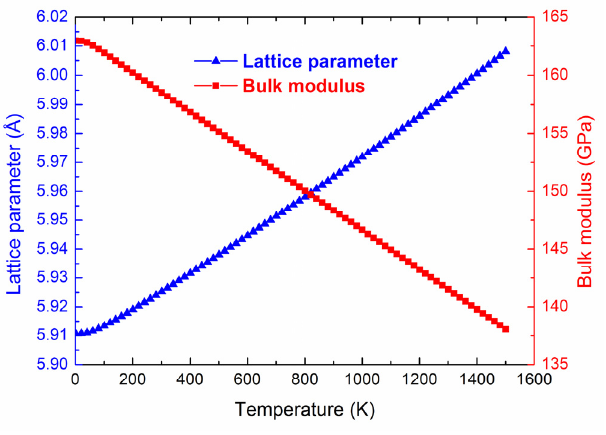
Figure 2. Temperature dependence of the lattice parameter and bulk modulus of AlNi 2 Ti.